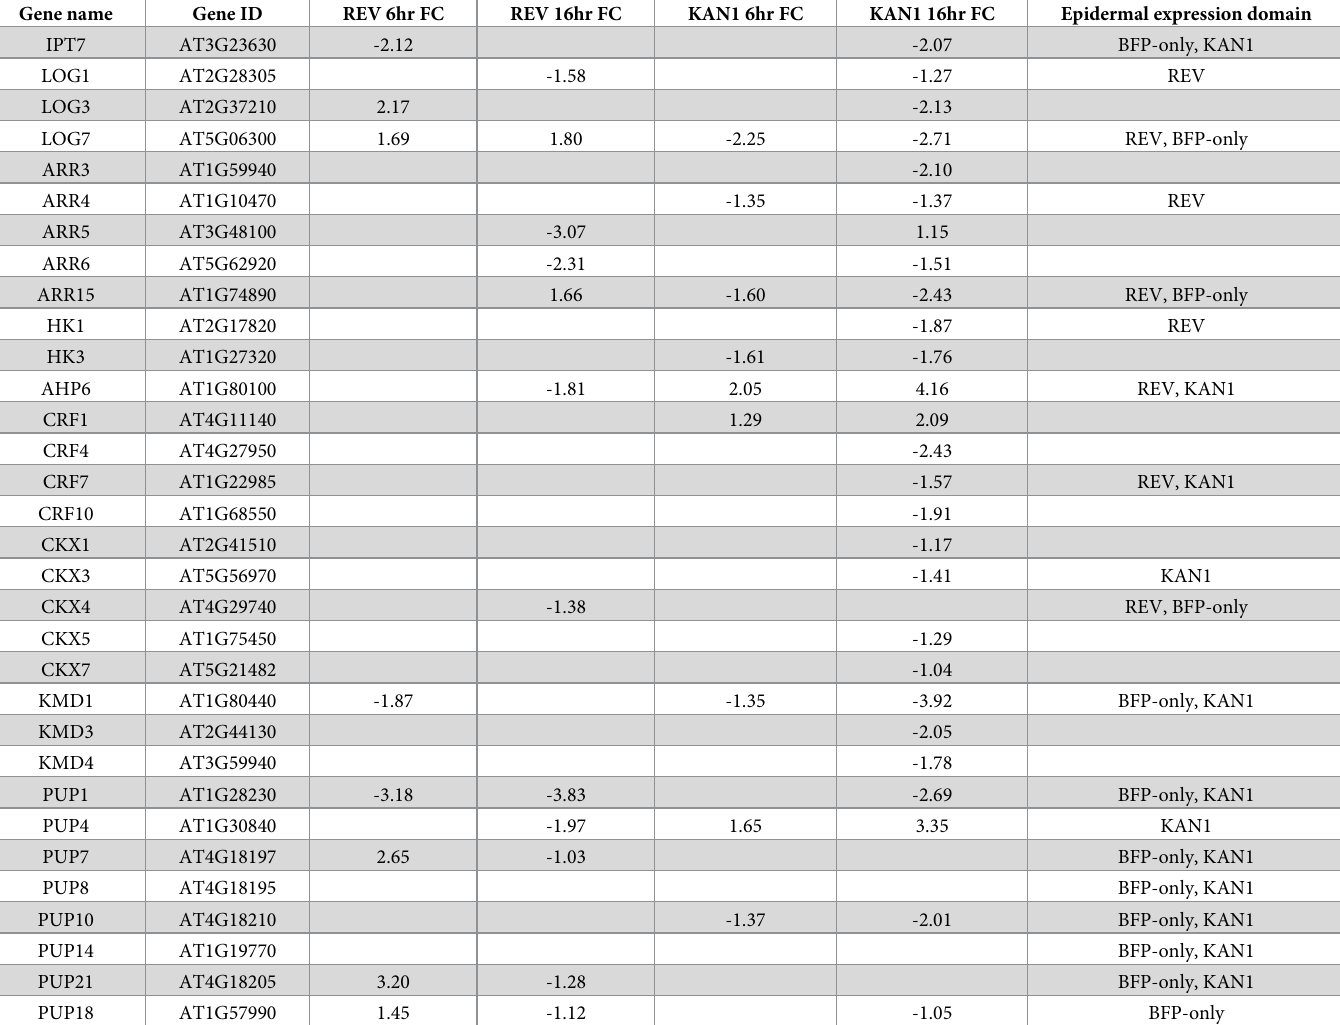
Table 2. Regulation and expression of genes involved in cytokinin